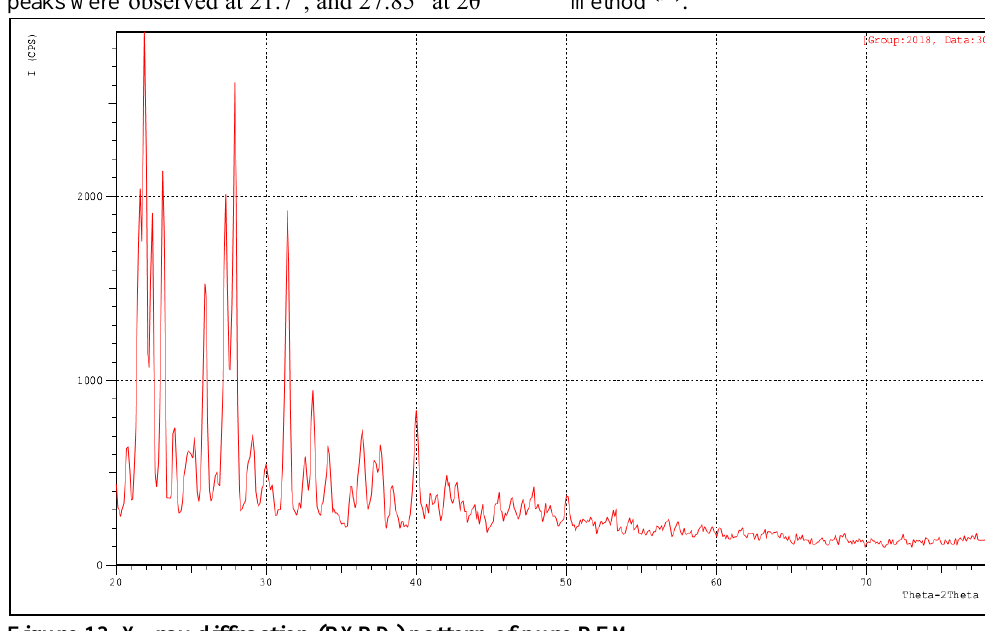
Figure 13. X- ray diffraction (PXRD) pattern of pure REM